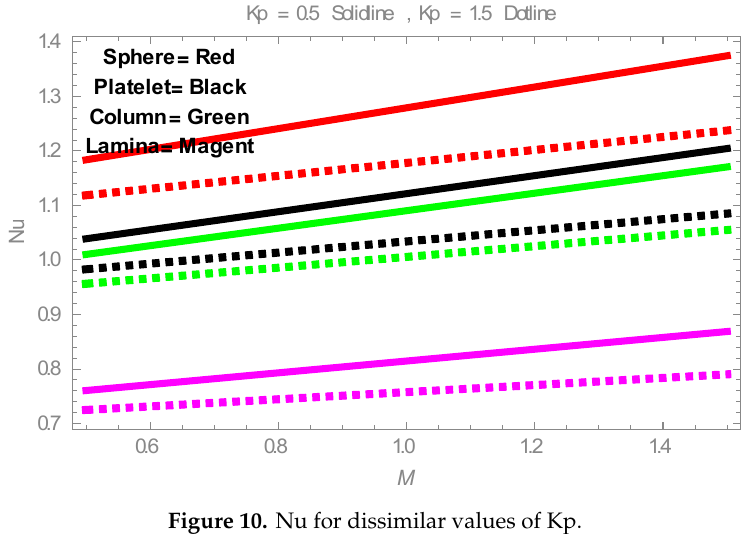
Figure 10. Nu for dissimilar values of Kp.